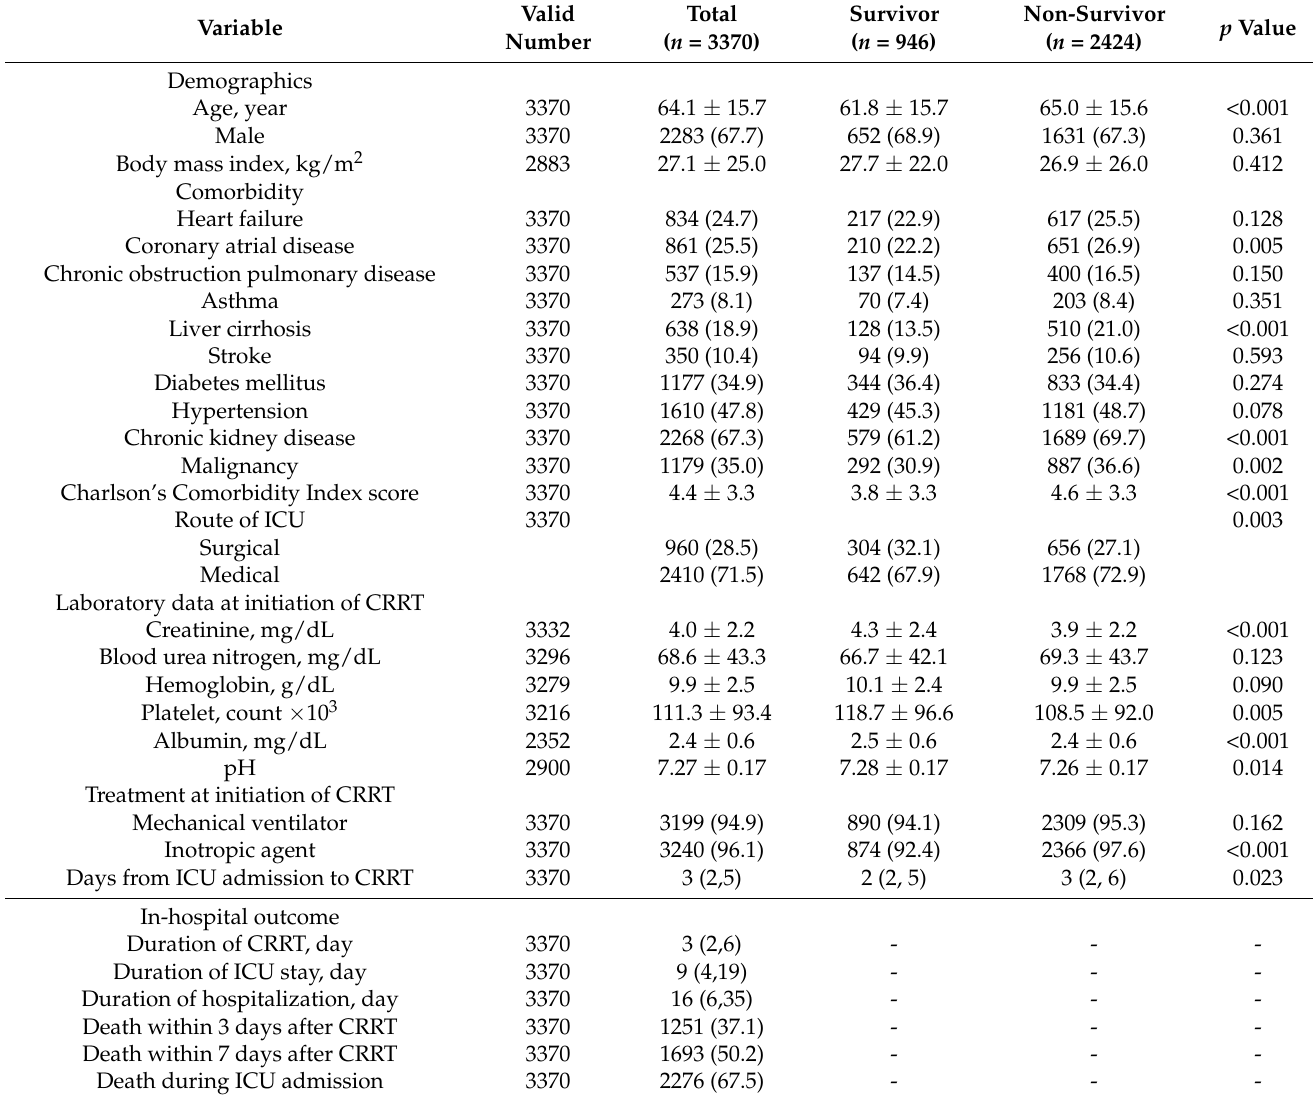
Table 1. Patient characteristics according to the survival status at the day of discharge from the index